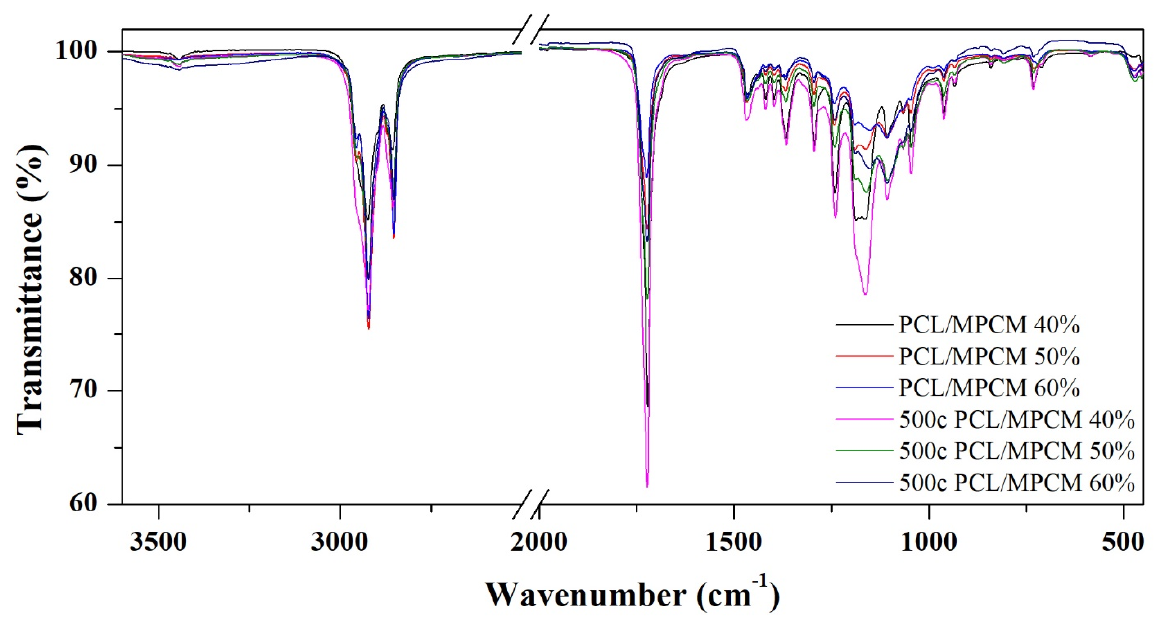
Figure 12. FT-IR spectra before and after the thermal cycling of MPCM CSS-PCM from 40 to 60 wt.%.